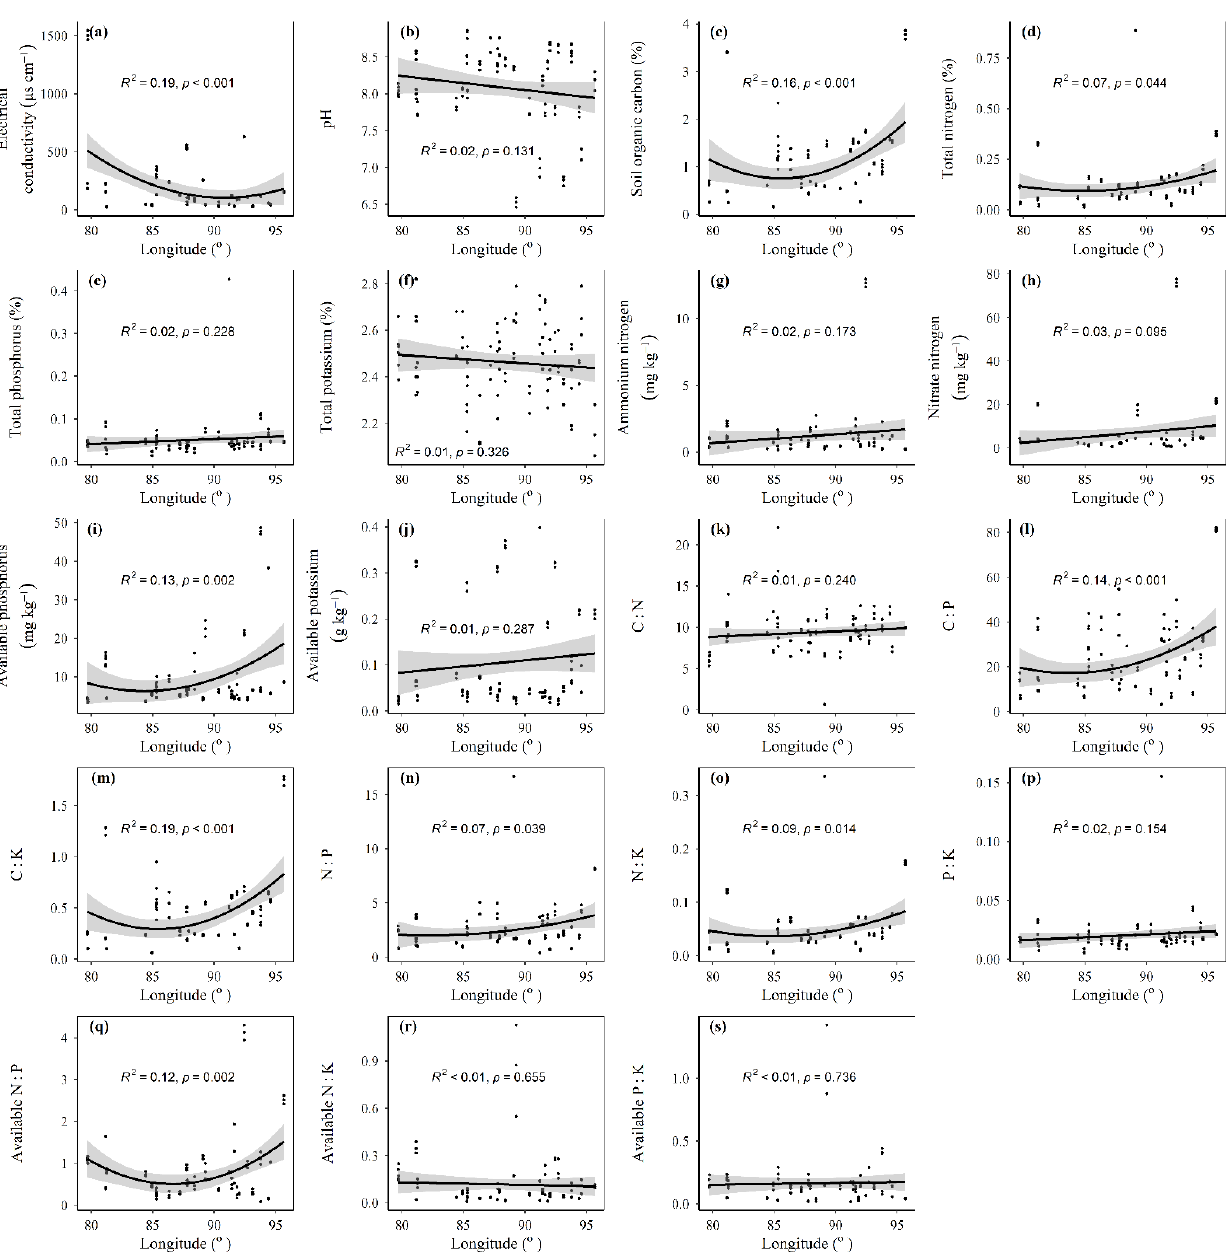
Figure A7. Relationships of longitude with soil ( a ) electrical conductivity, ( b ) pH, ( c ) soil organic carbon (SOC), ( d ) total nitrogen (TN), ( e ) total phosphorus (TP), ( f ) total potassium (TK), ( g ) ammonium nitrogen (NH 4+ -N), ( h ) nitrate nitrogen (NO 3 − -N), ( i ) available phosphorus (AP), ( j ) available potassium (AK), ( k ) ratio of SOC to TN (C:N), ( l ) ratio of SOC to TP (C:P), ( m ) ratio of SOC to TK (C:K), ( n ) ratio of TN to TP (N:P), ( o ) ratio of TN to TK (N:K), ( p ) ratio of TP to TK (P:K), ( q ) ratio of available nitrogen to AP (available N:P), ( r ) ratio of available nitrogen to AK (available N:K) and ( s ) ratio of AP to AK (available P:K) at a depth of 10–20 cm.